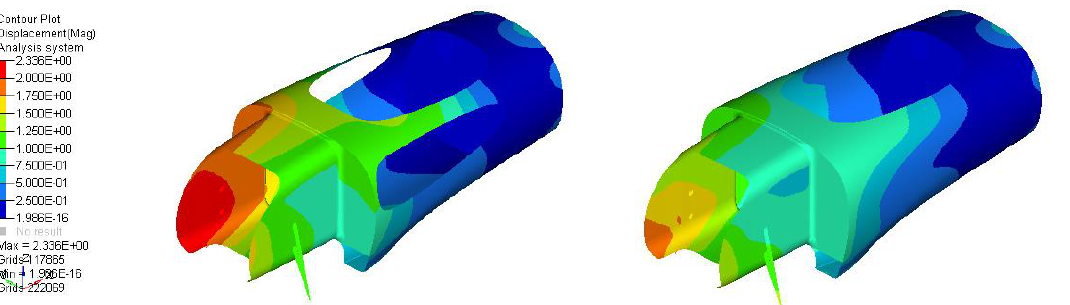
Figure 6. Rollover displacements without ( left ) and with ( right ) windows.